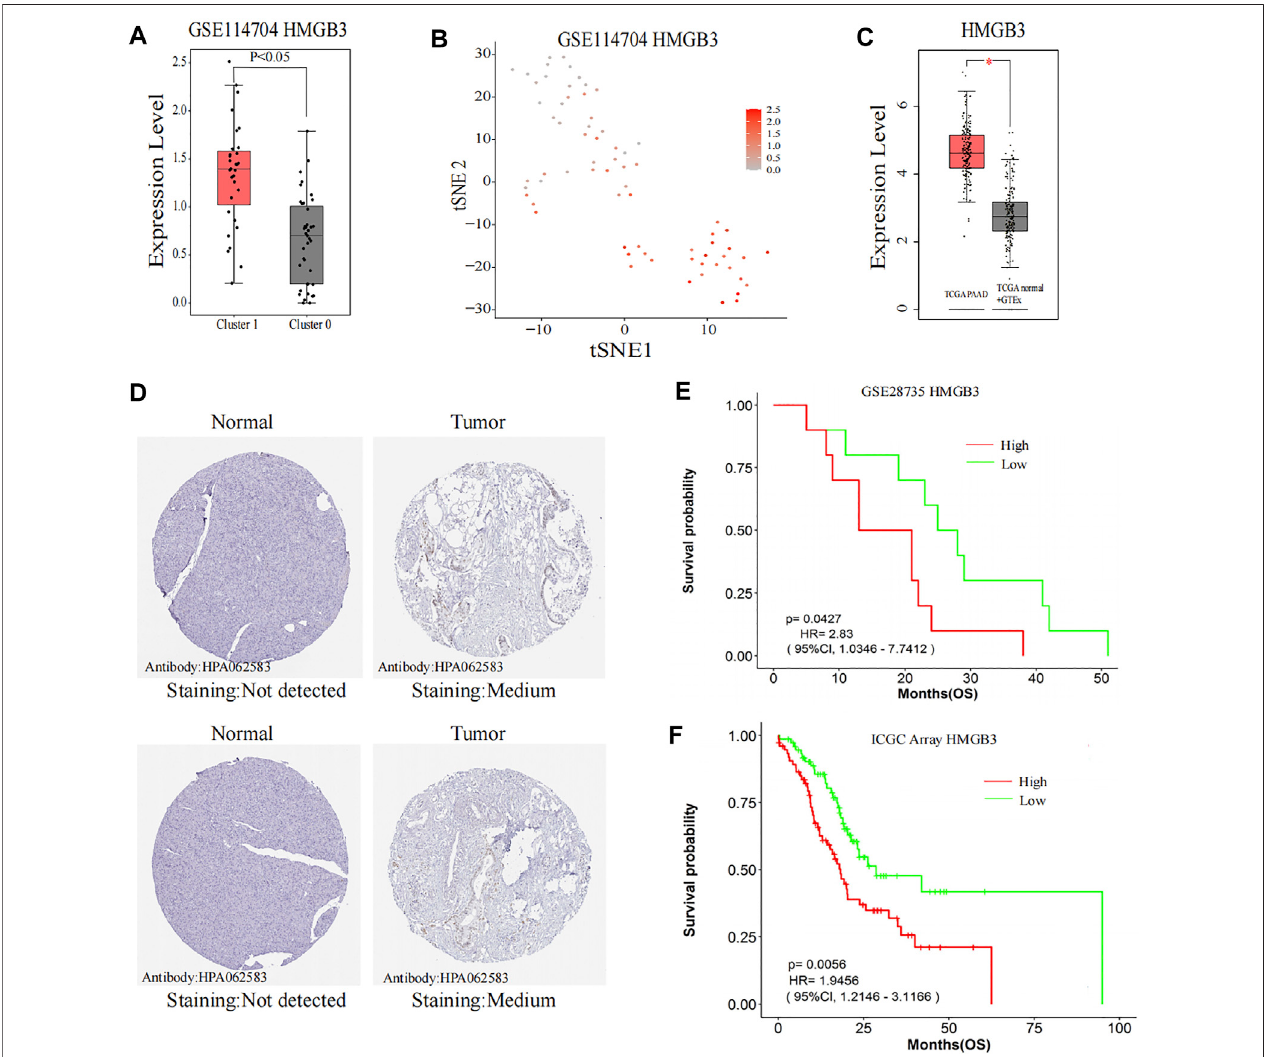
FIGURE 8 | Further research on the hub gene. (A,B) Comparison of HMGB3 expression between Cluster 0 and Cluster 1. (C) HMGB3 expression in the TCGA pancreatic tumors with corresponding matched normal tissue and GTEx pancreatic tissue. (D) Representative immunohistochemistry images of HMGB3 in PAAD and noncancerous pancreatic tissues derived from the HPA database. (E) Comparisons of OS curves between high and low expression of HMGB3 in GSE28735. (F) Comparisons of OS curves between high and low expression of HMGB3 in ICGC Array. TCGA, The Cancer Genome Atlas; ICGC, International Cancer Genome Consortium; GTEx, The Genotype-Tissue Expression; HPA, the Human Protein Atlas; HMGB3, high-mobility group box 3; PAAD, pancreatic adenocarcinoma; OS, overall survival; HR, hazard ratio; CI, con fi dence interval.